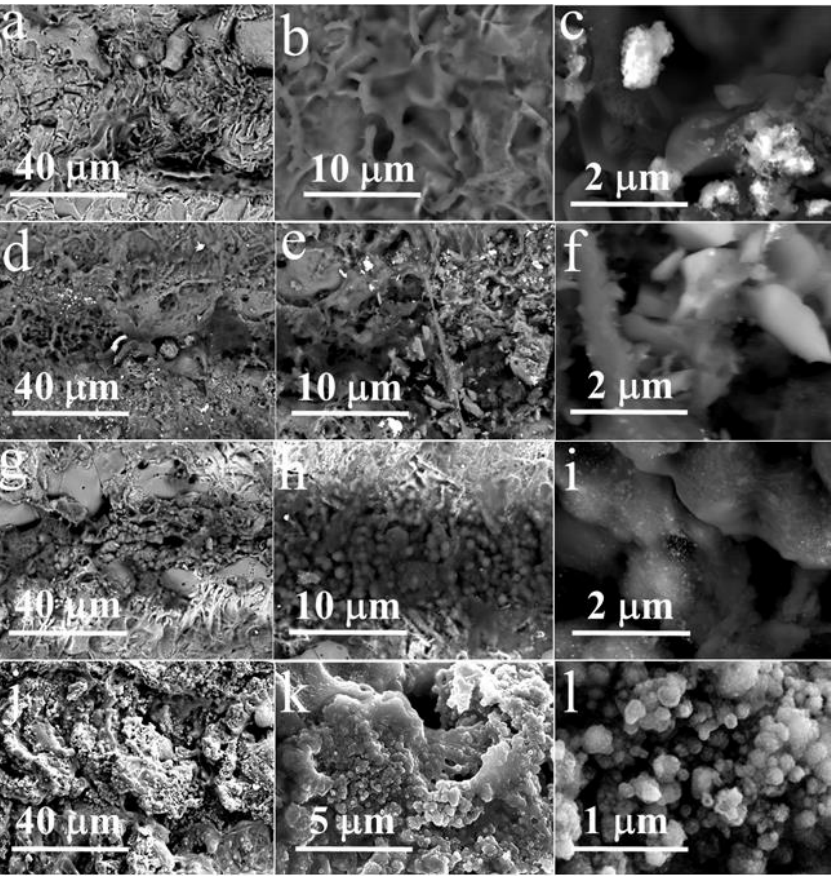
Figure 2. SEM images of ( a – c ) iridium (Ir), ( d – f ) iridium-platinum (Ir-Pt), ( g – i ) iridium-gold (Ir-Au) and ( j – l ) iridium-gold-platinum (Ir-Au-Pt) microstructures.